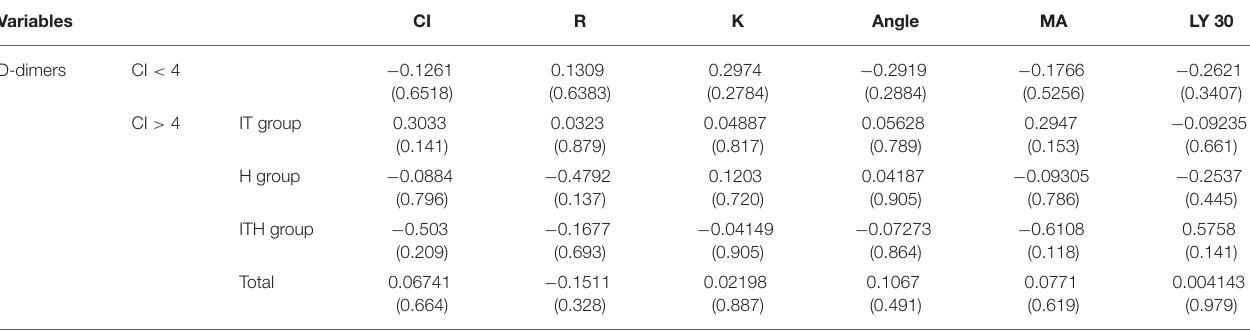
TABLE 3 | Spearman’s correlation coefficients ( p -values) for D-dimer concentrations and thromboelastography (TEG) variables with coagulation index.